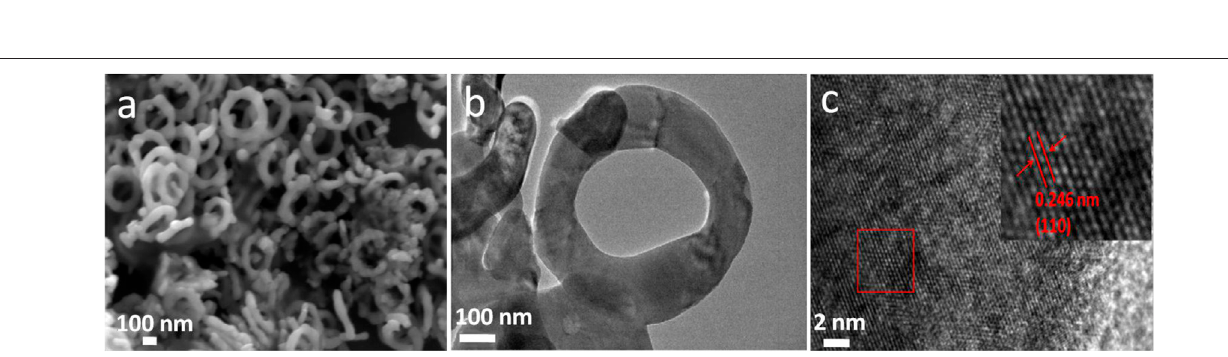
Frontiers in Energy Research |